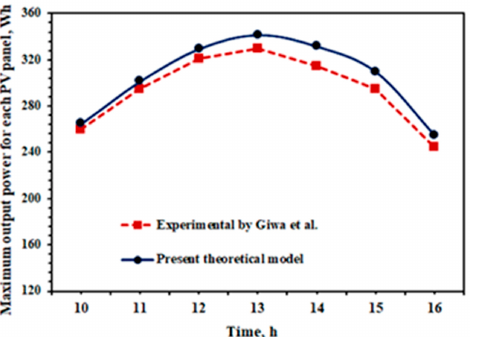
Figure 2. Model validation of the solar photovoltaic/thermal panels [33].